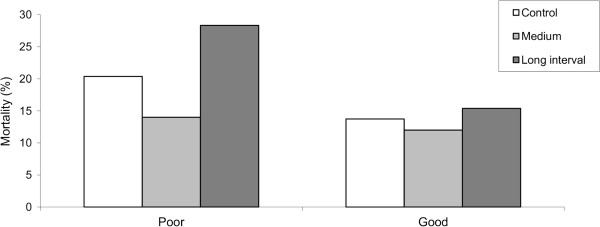
Interaction between inherent swimming performance and exercise training on disease resistance. Only those regimes included in the gene expression analysis are displayed. These reflect the lower (Medium), middle (Control) and higher (Long interval) mortalities found in response to IPN infection. Data is shown within poor (left) and good (right) swimmers. Though not significant, differences in mortalities were larger between poor and good swimmers for the Long interval, smaller for Control and minimum for the Medium intensity regime. Initial number of fish on the challenge ranged from 100 to 112 per regime.